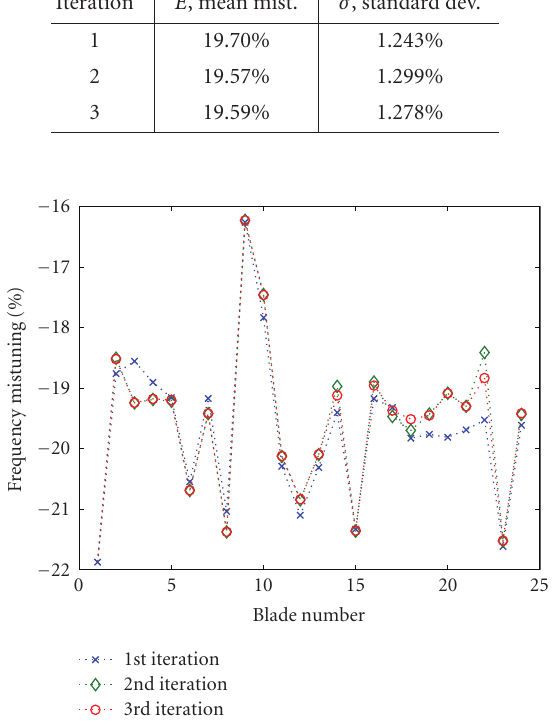
Figure 9: Mistuning parameters (% frequency).